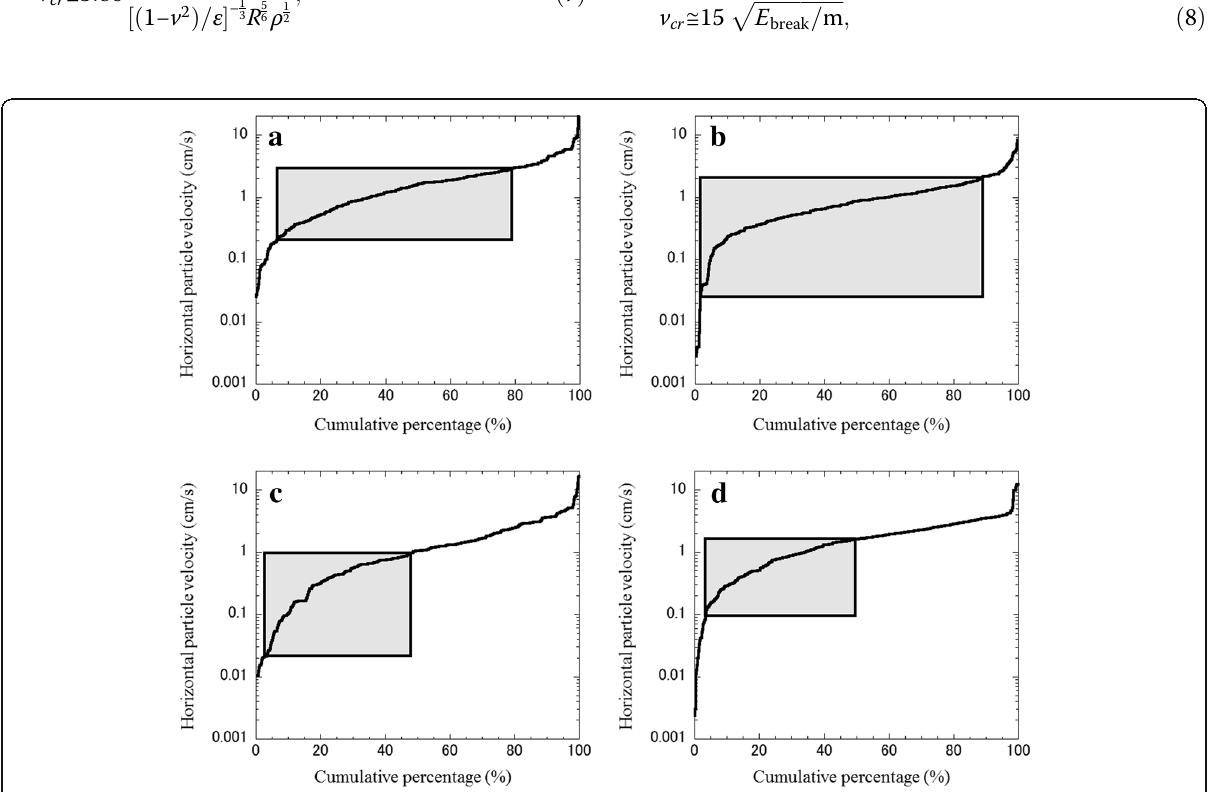
Fig. 9 Horizontal particle velocity distribution just below the funnel aperture plotted against cumulative percentage for a 50 μ m glass beads, b 100 μ m glass beads, c alumina particle, and d silica sand. Quadrangles show the ranges of the critical collision velocity for equal-size agglomerates corresponding to 10 – 90% of the total number of